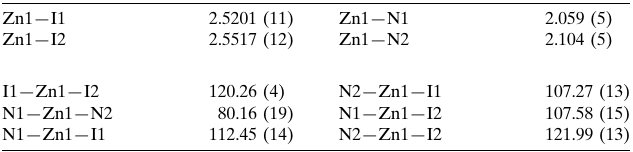
Selected geometric parameters (A˚ , (cid:1)